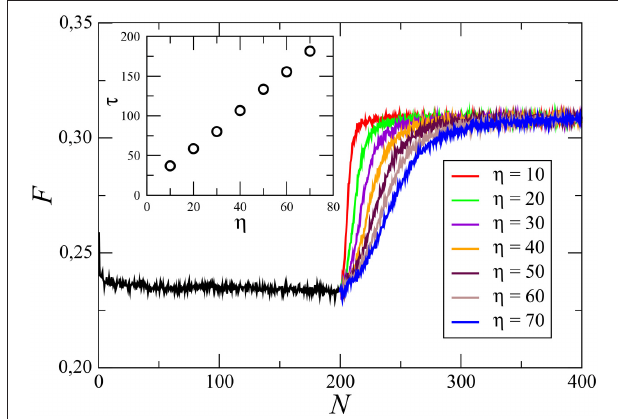
FIGURE 3 | (Color online) Change in the oil fractional-flow ( F ) during the simulation as a function of the number of network pore-volumes ( N ) of fluids passed through any cross-section of the network. Here the network is of size 40 × 40 links with oil saturation S = 0.3 and Ca = 10 − 1 . The initial part of the plot ( N < 200 ) shows the change in F in an oil-wet system where it approaches to a steady state with F ≈ 0.235 . The wettability alteration starts at N = 200 , where results for different simulations with different values of η (the number of pore volumes of water needed to pass through one pore to reach the wetting angle to 90 ◦ in that pore) are plotted in different colors. The system evolves to a new steady-state where F fluctuates around a higher average value. Different values of η only affects the rate of change in F but leads to the same average F . In the inset we plot τ , the number of network pore-volumes of fluids passed through the network to reach the steady-state after wettability alteration is initiated, as a function of η . τ is proportional to the total time to reach steady state which increases linearly with η as seen in the inset. A higher value of η results in a longer time to reach the new